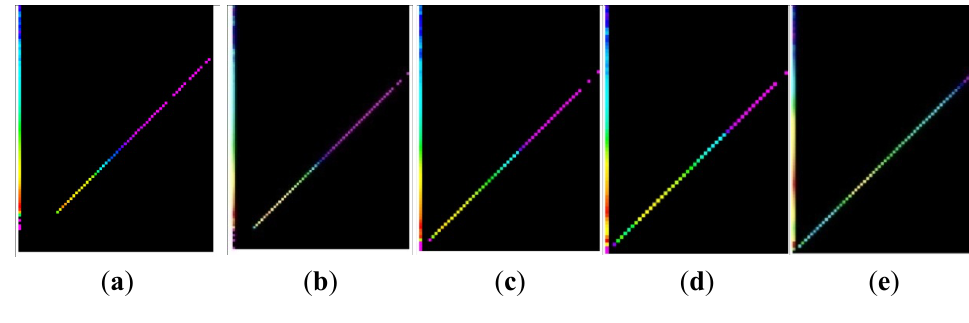
Figure 3. Digital numbers in the overlapping area of the RapidEye blue